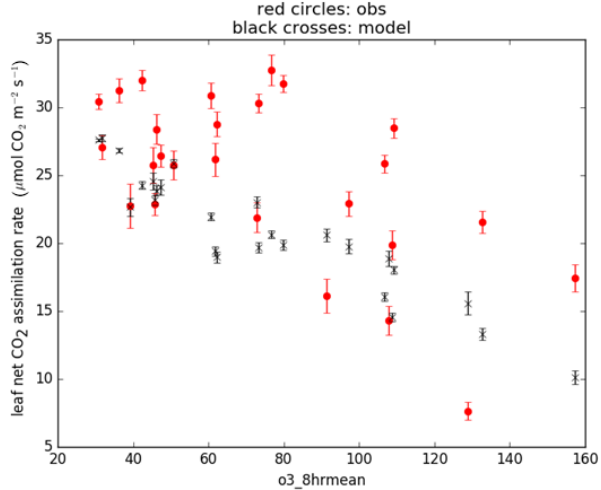
Figure 2. Net leaf CO 2 assimilation rate for calibrated JULES, sim- ulated using the Leaf Simulator (black crosses) and observations from Betzelberger et al. (2012) (grey circles). X axis is the daytime 8h mean O 3 concentration